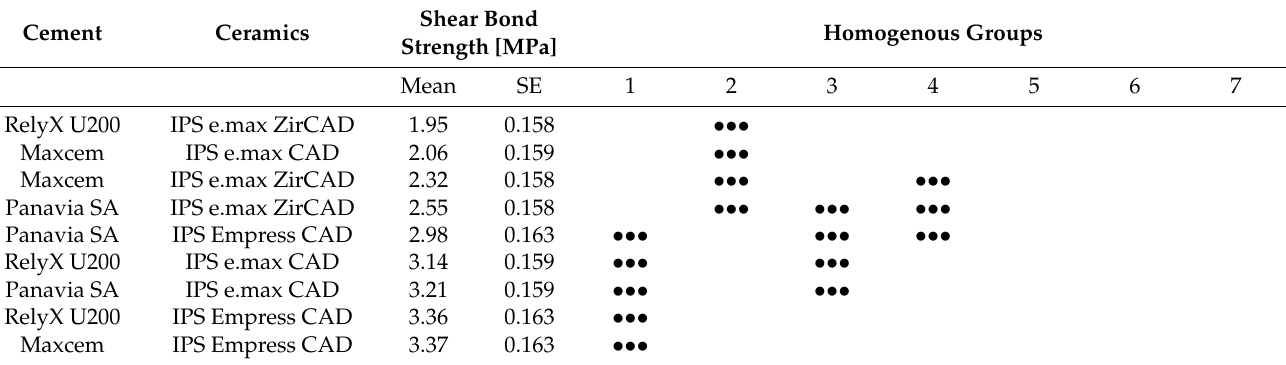
Table A2. Tabularized representation of the results from the post-hoc Tukey’s HSD test for differences between means of the shear bond strength in particular samples defined by ceramics and